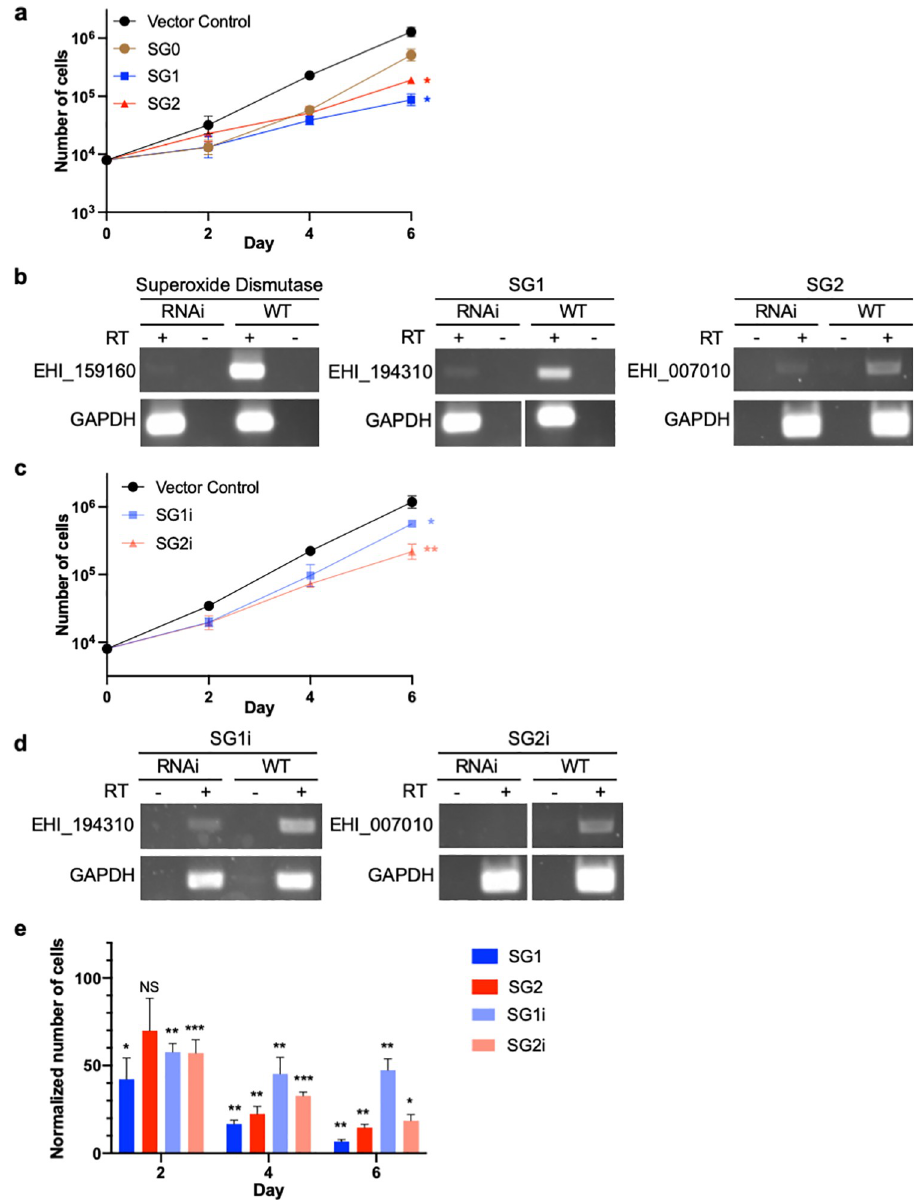
Fig 5. Identification of slow growth mutants, with phenotypes that are reproducible in independently-generated knockdown mutants. a, Growth analysis of clonal knockdown mutant lines obtained from screening the heterogeneous library transfectants for growth defects. Amoebae transfected with pTriggerAdaptor (vector control) were used as a negative control, and superoxide dismutase (“SG0”; EHI_159160) knockdown mutants were used as a positive control for slow growth. The library mutants SG1 and SG2 each exhibited a significant growth defect when compared to vector control transfectants. b, RT-PCR analysis demonstrates that the genes corresponding to the plasmid inserts in SG1 and SG2 (EHI_194310 and EHI_007010, respectively), were knocked down. c, Knockdown mutants were independently generated by using fragments of these genes that differed from the fragments in the library plasmids. These independent mutants are referred to as SG1i and SG2i. Growth analysis was performed using heterogeneous stable transfectants, and growth mutants exhibited a significant growth defect when compared to vector control. d, RT-PCR analysis demonstrates that EHI_194310 and EHI_007010 were knocked down in SG1i and SG2i mutants, respectively. e, Growth phenotypes in SG1, SG2, SG1i and SG2i. Growth values for each mutant were normalized to vector control transfectants. Mutants exhibited statistically significant growth defects relative to vector control transfectants.